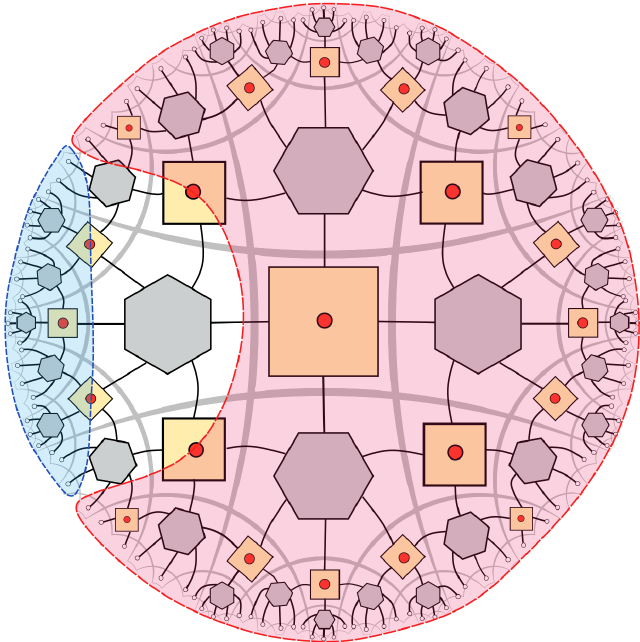
Figure 25. Complementary recovery based on local moves can fail even with boundary bipartitions that are not